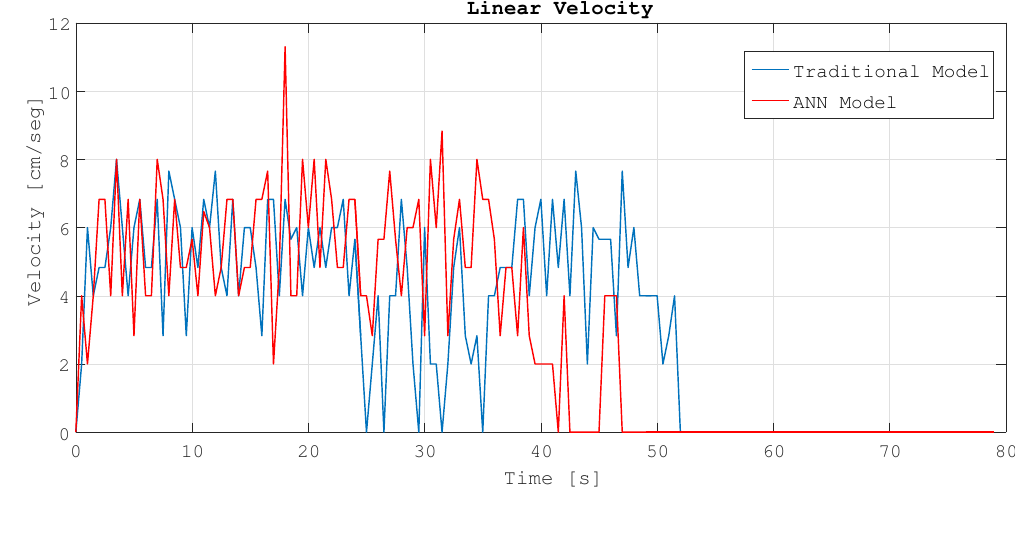
Figure 20. Linear